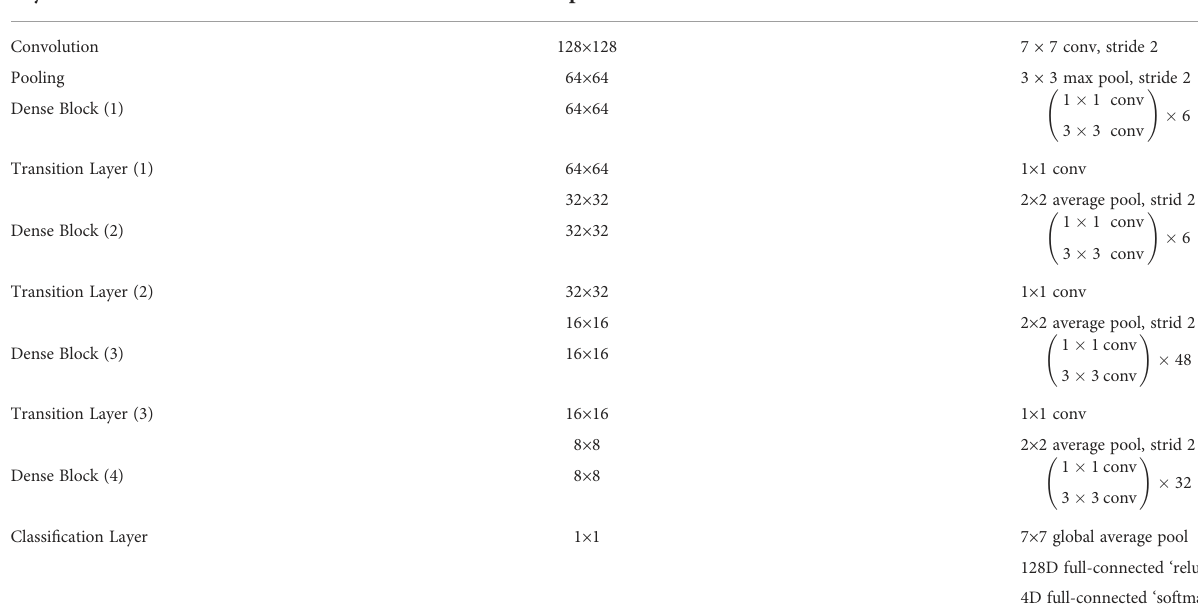
TABLE 5 DenseNet architectures.